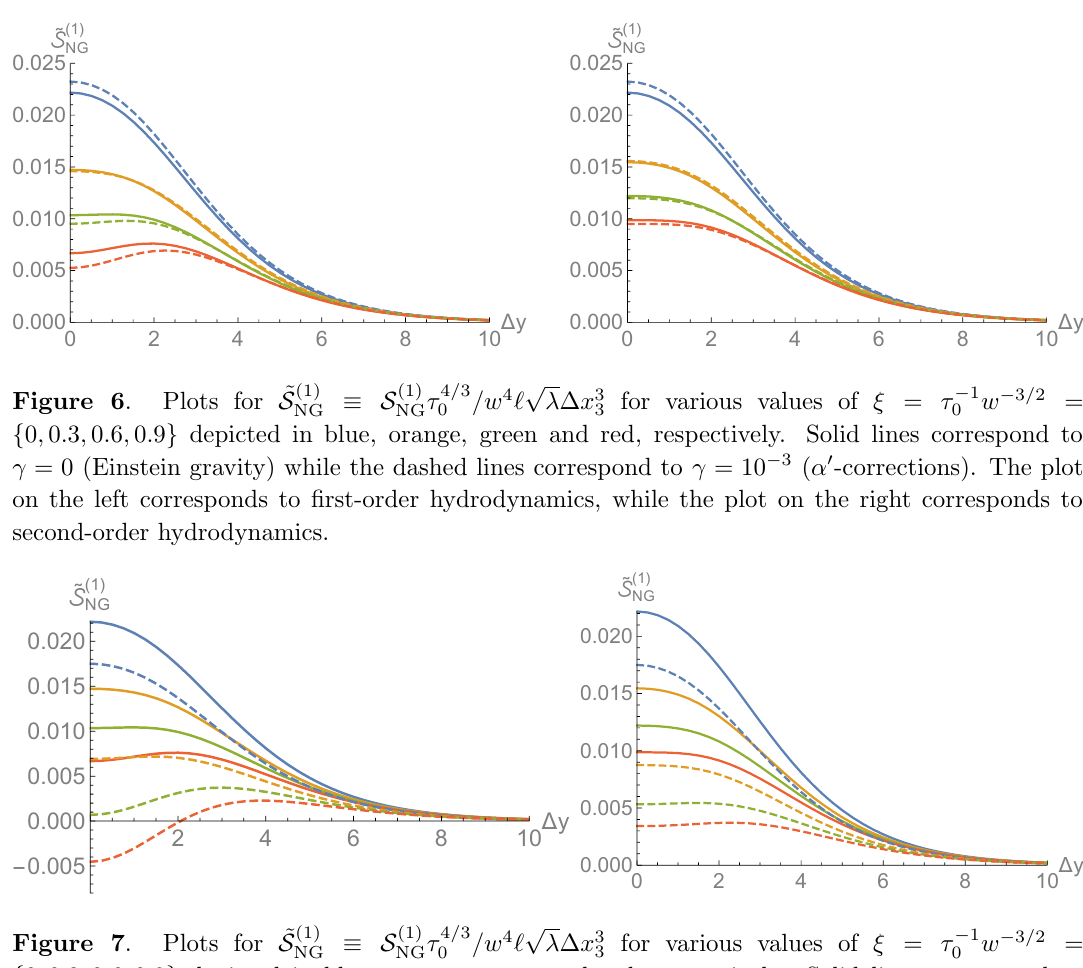
p (cid:17) S (1) (cid:28) 4 = 3 =w 4 ‘ (cid:21) (cid:1) x 3 for various values of (cid:24) = (cid:28) (cid:0) 1 3 0 NG NG = (cid:0) 0 : 2. The plot on the left GB